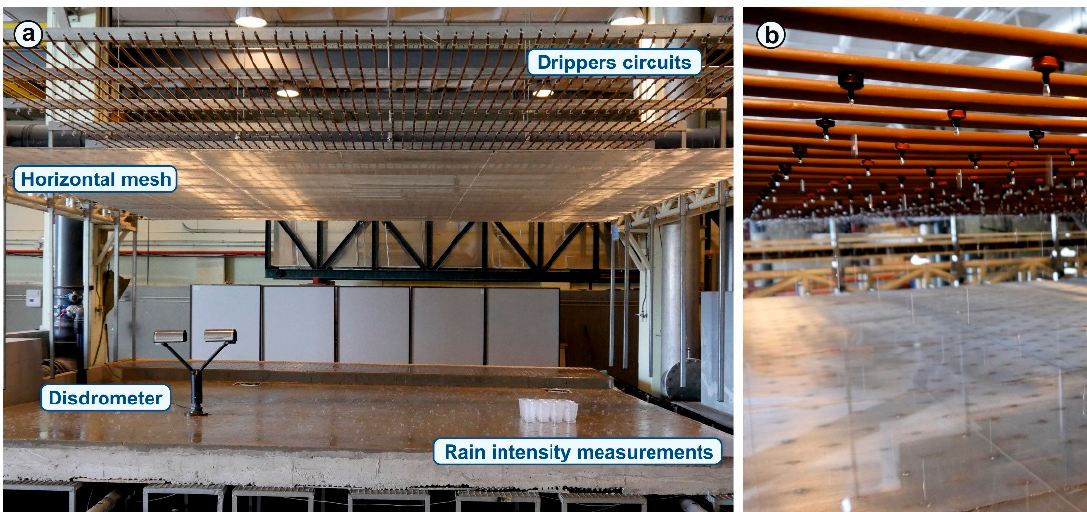
Figure 1. ( a ) General image of the rainfall simulator in its final configuration above the urban drainage physical model. Disdrometer and vessels for measuring rain intensity are also shown. ( b ) Detail of both types of drippers inserted in the circuits above the horizontal mesh.